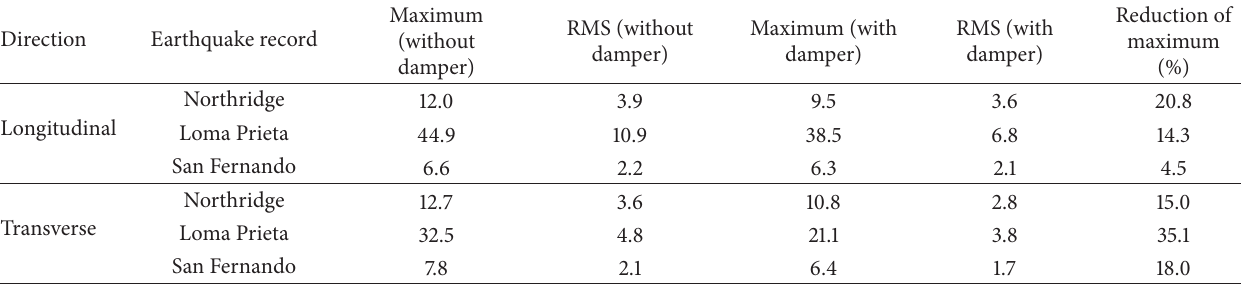
Table 4: Maximum and RMS values of the acceleration responses of the bridge deck (m/s 2 ). Direction